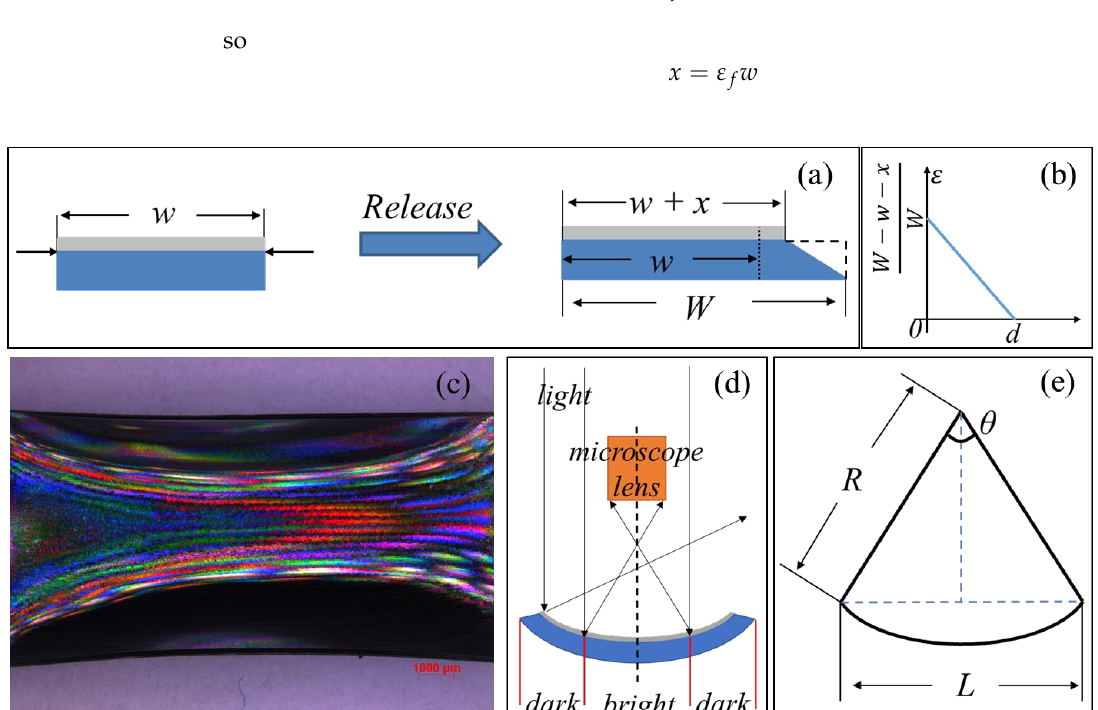
Figure 3. ( a ) For the convenience of calculation, the bending film is equivalent to the flattened film; w is the width of the substrate under prestrain, w + x is the width of the film after releasing the prestrain, W is the width of the lower surface of the substrate after releasing the prestrain. ( b ) Strain variation of substrate from the top surface to bottom surface; d is the thickness of the substrate. ( c ) Optical image of bent film under vertical light source. ( d ) Schematic representation of the bright and dark areas of the film. ( e ) The relationship between the width of bright areas and the curvature radius of thin films; L is the width of the bright area of the curved film, R is the corresponding curvature